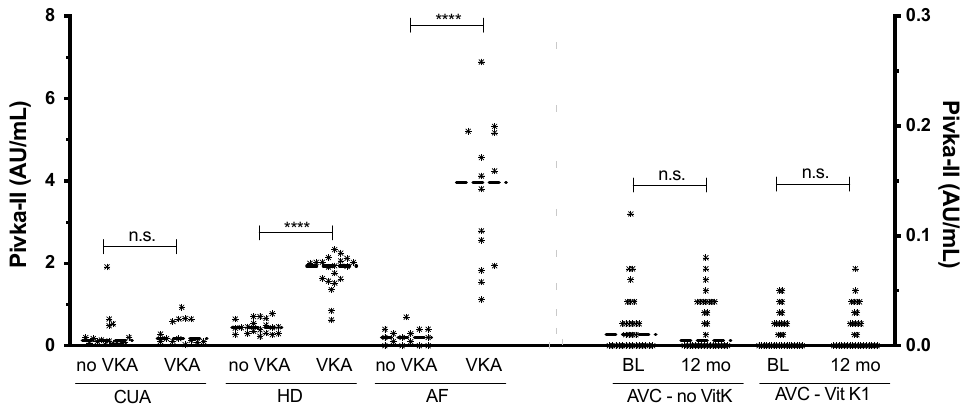
Figure 3. PIVKA-II measurements of all cohorts. HD and AF patients had higher PIVKA-II levels with VKA use. CUA and AVC cohorts did not change with VKA or vitamin K supplementation, respectively. CUA, HD and AF values correspond to the left Y-axis, and AVC values correspond to the right Y-axis. The dash indicates the median. Significance levels: n.s. = p > 0.05; **** = p ≤ 0.0001.